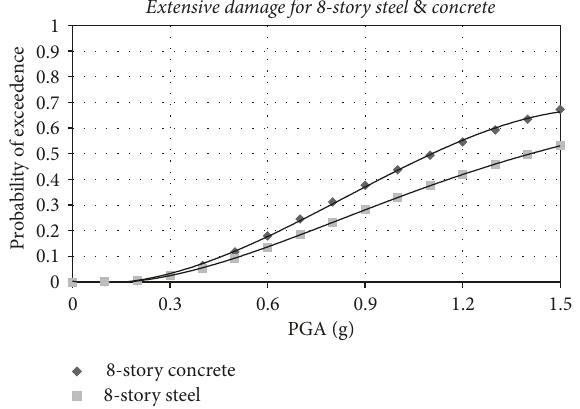
Figure 12: Comparison of the fragility of the 5-story steel and RC frame buildings for the moderate damage state.